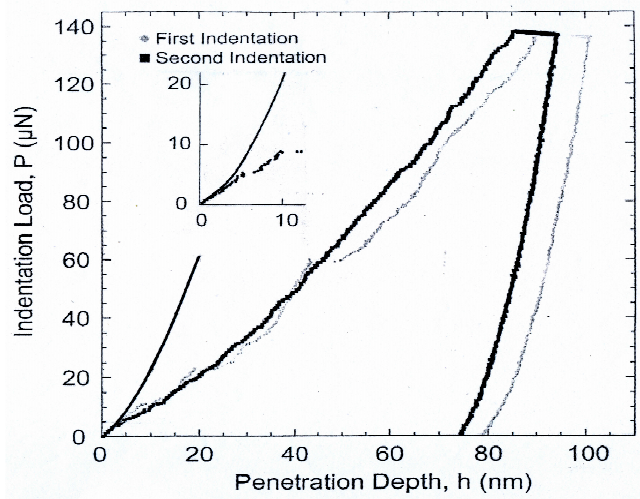
Figure 1. Composite graph for two nano-indentation P − h trajectories obtained in tests performed on a ( − 210) AP crystal surface; as adapted from the measurements reported in Ref